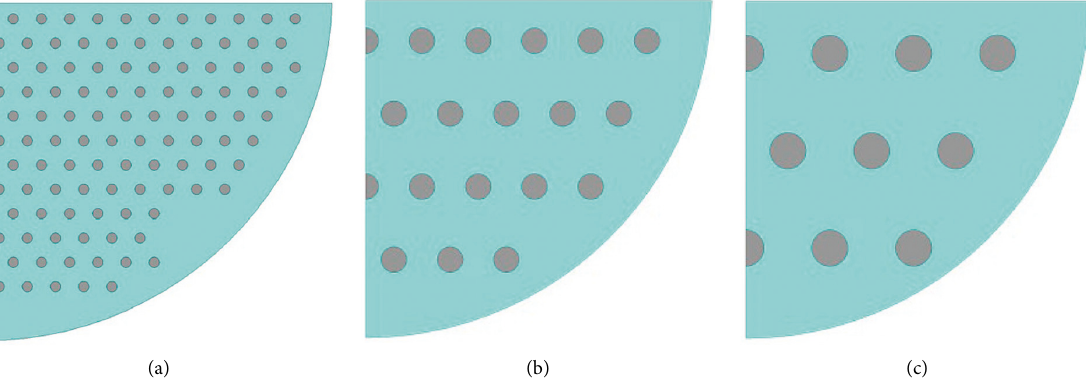
Figure 10: CAD model of tube arrays. (a) Model 1 (original model). (b) Model 2 (6:1) and (c) model 3